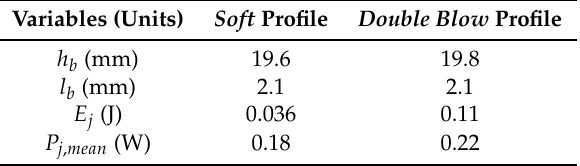
Table 1. Results of the presizing after the optimisation.